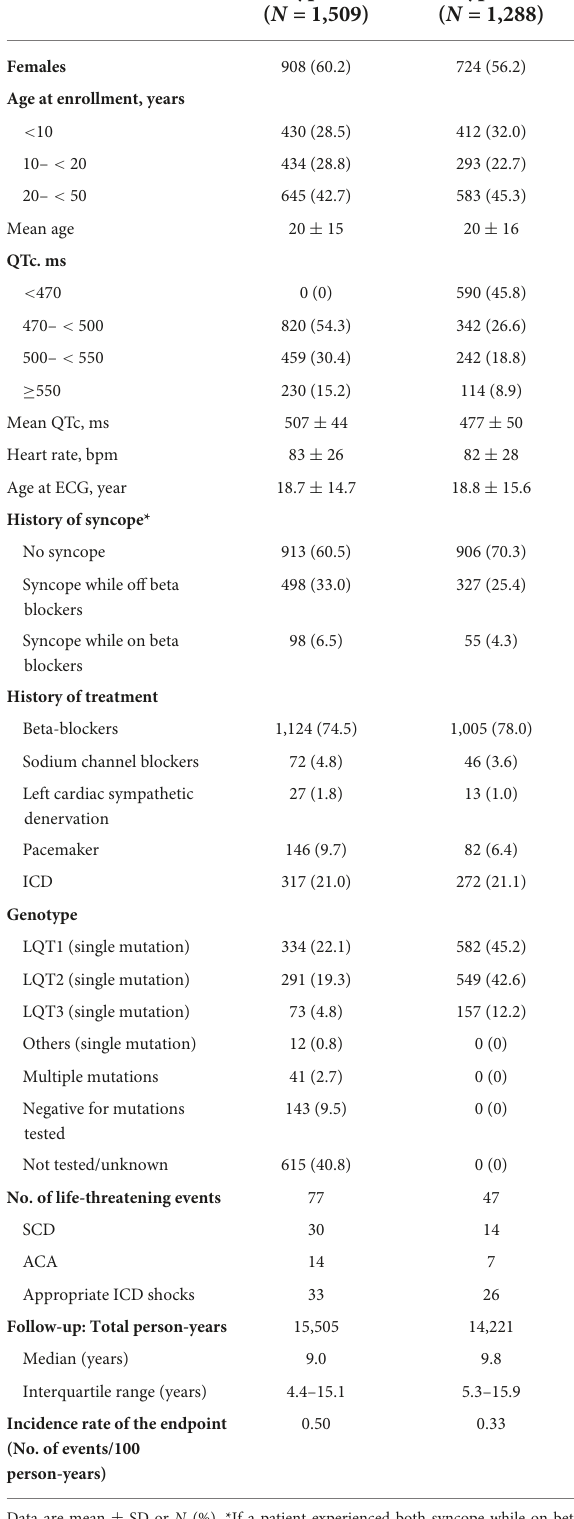
TABLE 1 Patients characteristics at enrollment in the Rochester phenotypic and genotypic